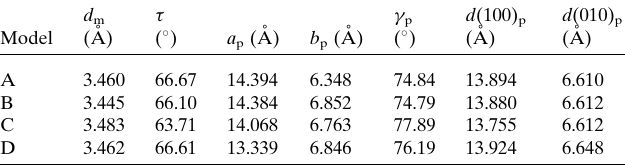
Table 4 Common features of models